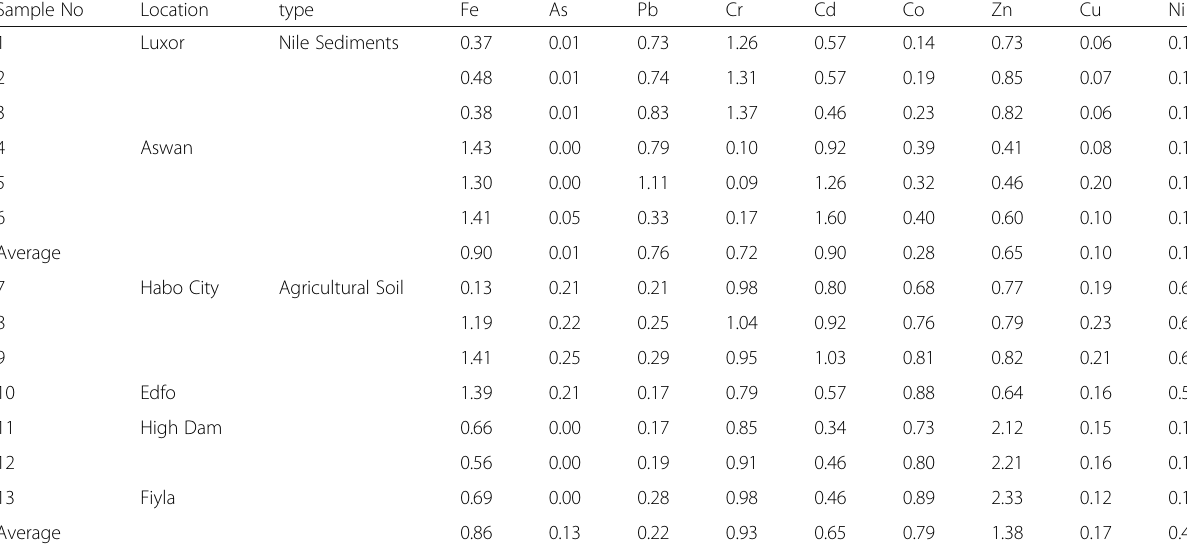
Table 2 Index of geoaccumulation (I geo ) values for the studied samples Sample No